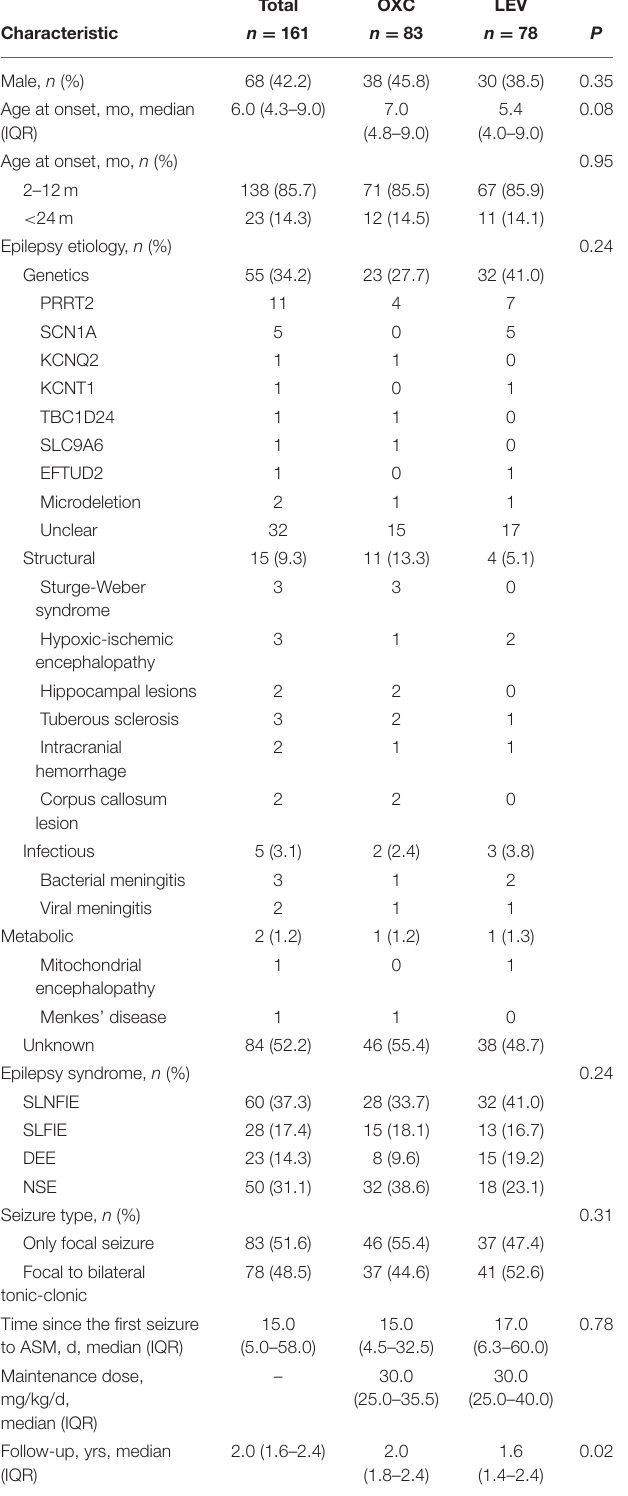
TABLE 1 | Patient baseline demographics and clinical characteristics ( n =